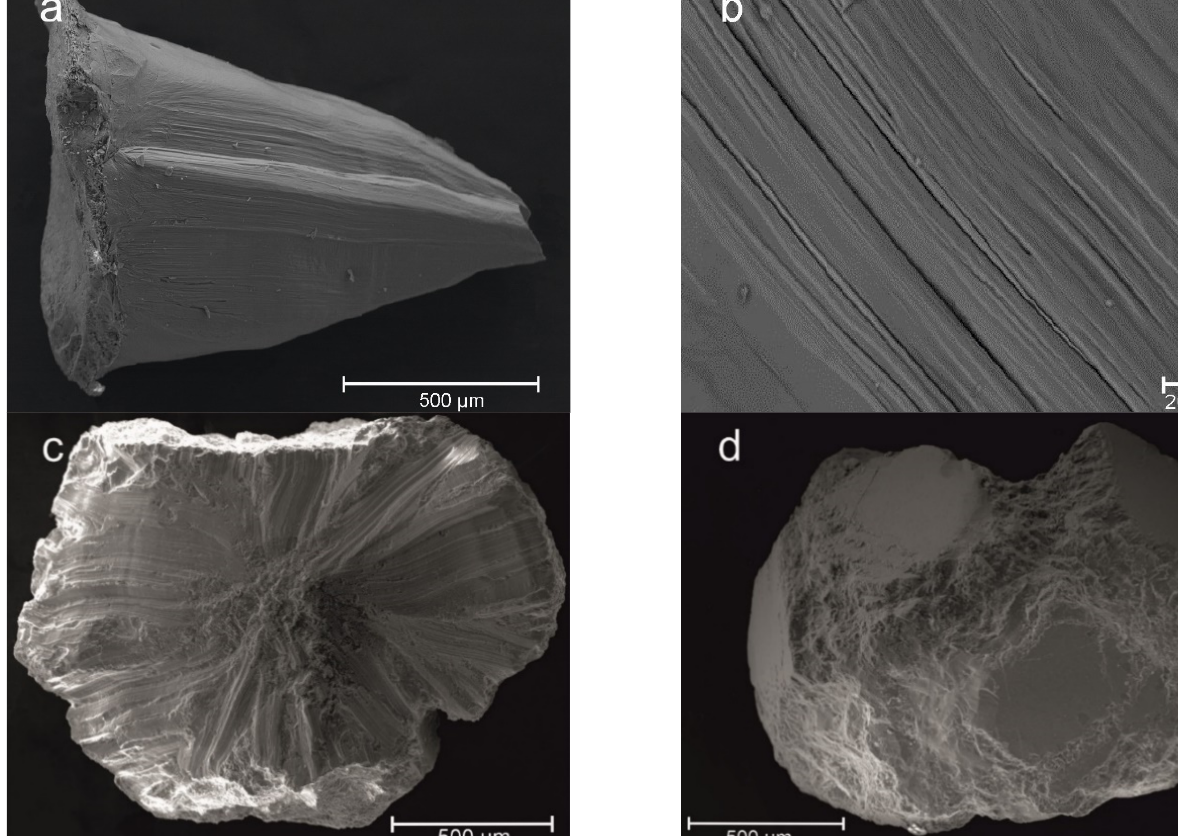
Figure 9. BSE-images of demantoids: ( a ) cone-shaped fragment; ( b ) surface of the chip in the “horsetail” inclusions plane; and ( c ) chip through the center of an opaque andradite crystal with negative-shaped ribs ( d ).